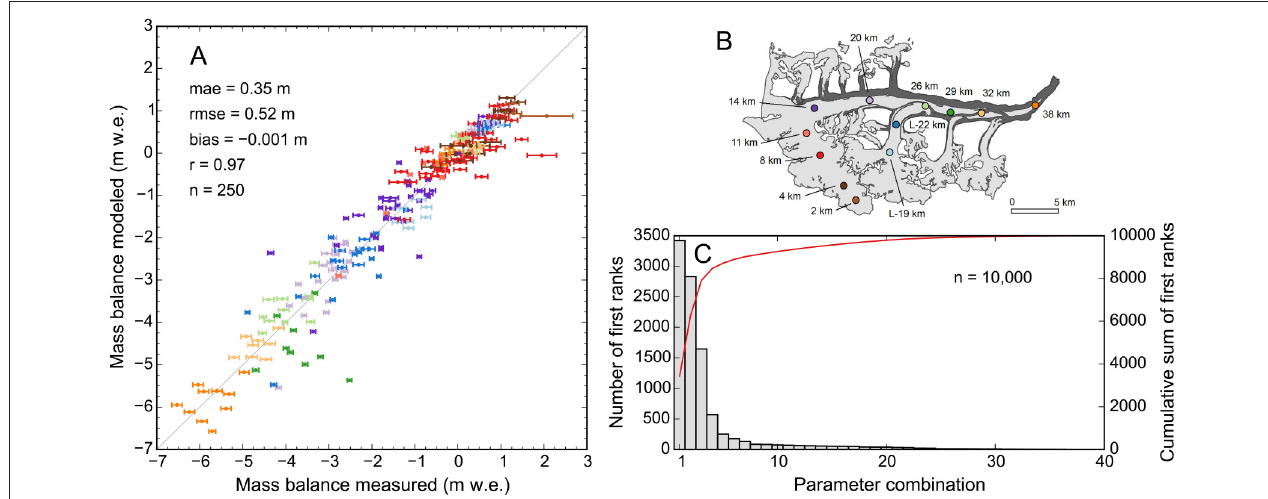
FIGURE 6 | (A) Modeled vs. measured point mass balances for one of the 40 best parameter combinations modeled ( f m = 0.9, r snow = 0.017, r ice = 0.035, s = 12.4, p = 1.12, d = 0.45). Error bars indicate the uncertainties in the measured mass balances. Colors distinguish index sites with locations shown in map (B) . The mass balances at the index sites 26, 29, and 32 km were observed before the deposition of the rockslide deposits. (C) Histogram indicating the number of first ranks accumulated during 10,000 model runs. The parameter combinations are numbered and ordered by the number of first ranks.